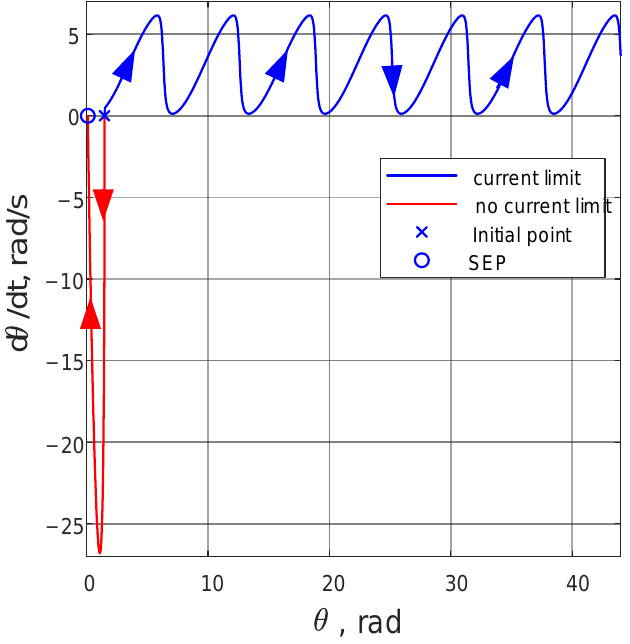
Figure 8. Phase portrait of different systems with the same initial operation point (SEP +0.44π , 0), red curve: system without current limit, blue curve: current-limited system.